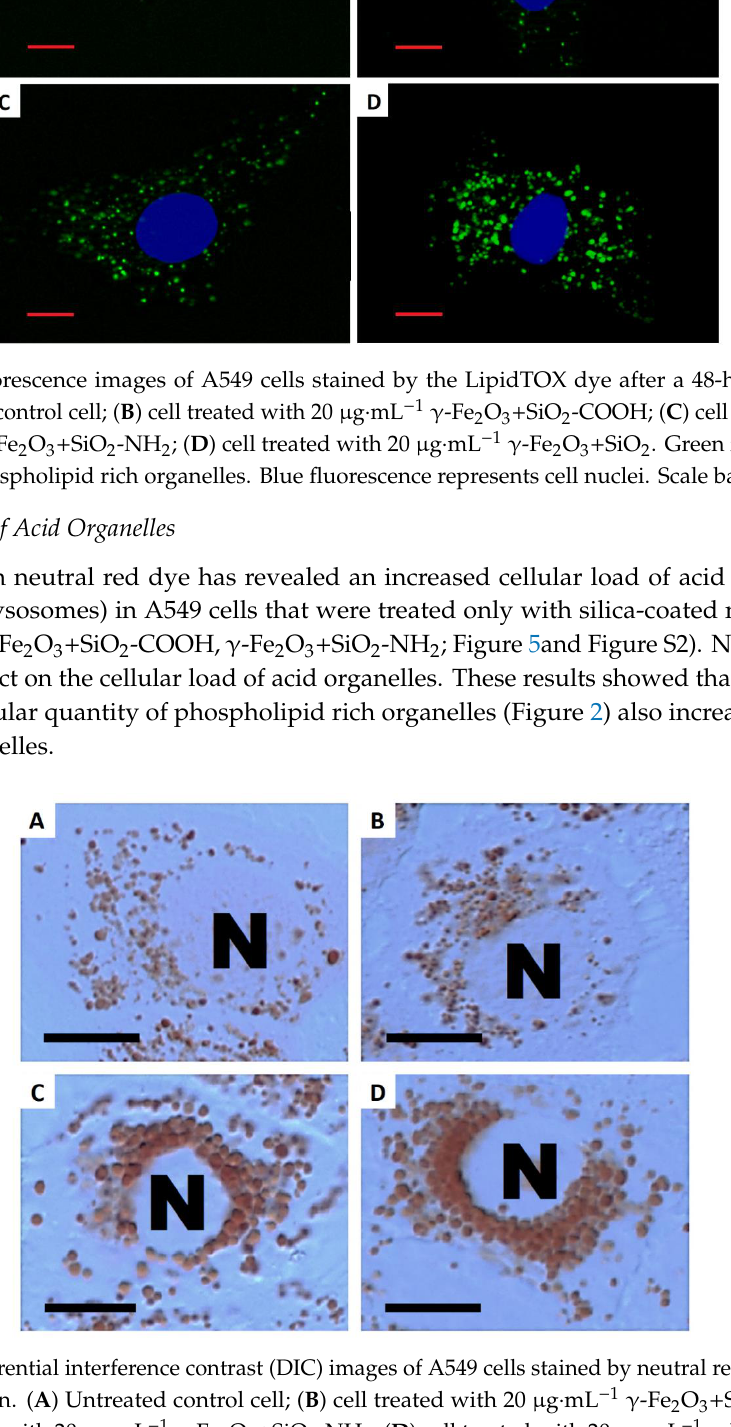
Figure 3. Concentration dependent increase in cellular quantity of phospholipid rich organelles in A549 cells after a 48-h incubation with maghemite nanoparticles. For each treatment condition, four independent biological repeats, where at least 100 cells were evaluated, were performed. Results are presented as an average evaluation score (+SD). Asterisk indicates a significant difference with respect to untreated control cells (dashed line; * equals p < 0.05; *** equals p < 0.001; one-way ANOVA,